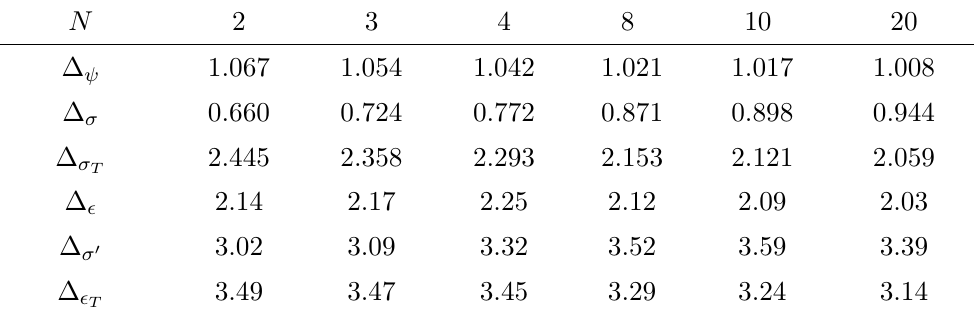
Table 2 . Dimensions of some of the low-dimensional operators in GNY models obtained in this work. Dimensions of , (cid:27) and (cid:27) T can be obtained from (cid:12)gures 1 and 2 directly. Other dimensions were obtained from zeros of the extremal functionals and are thus given to less precision. Conf. boot.